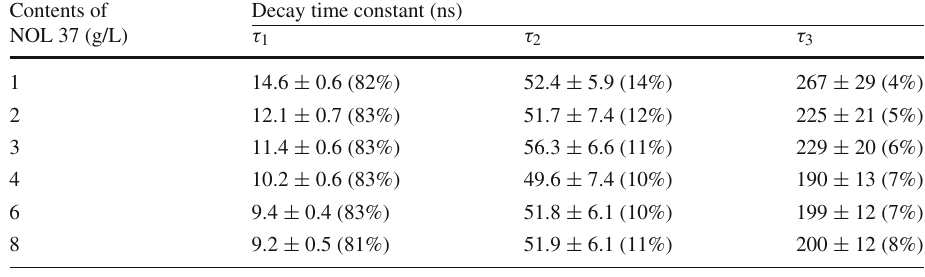
Table 1 Decay time constants of scintillation pulse of LAB-based scintillators with